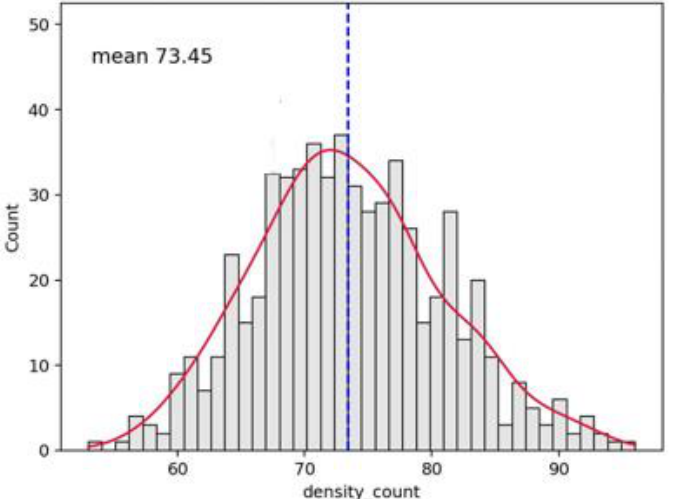
Figure 2. Histogram distribution of capillary density for the whole video (see Figure 1). The dashed line indicates the mean value (73.45 in this case); the red line interpolates the data for clearer reading.